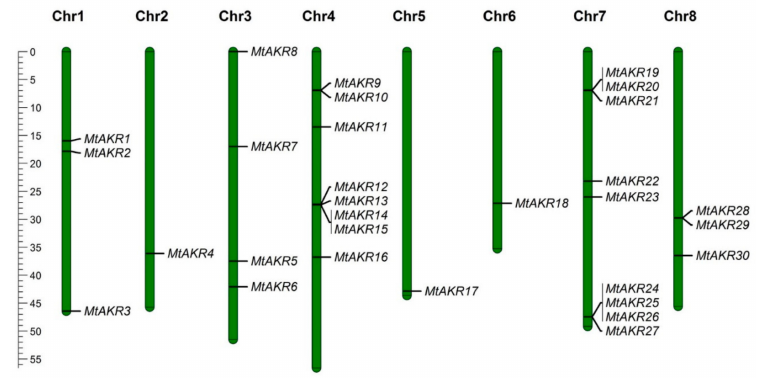
Figure 1. The chromosomal locations of the MtAKR genes.